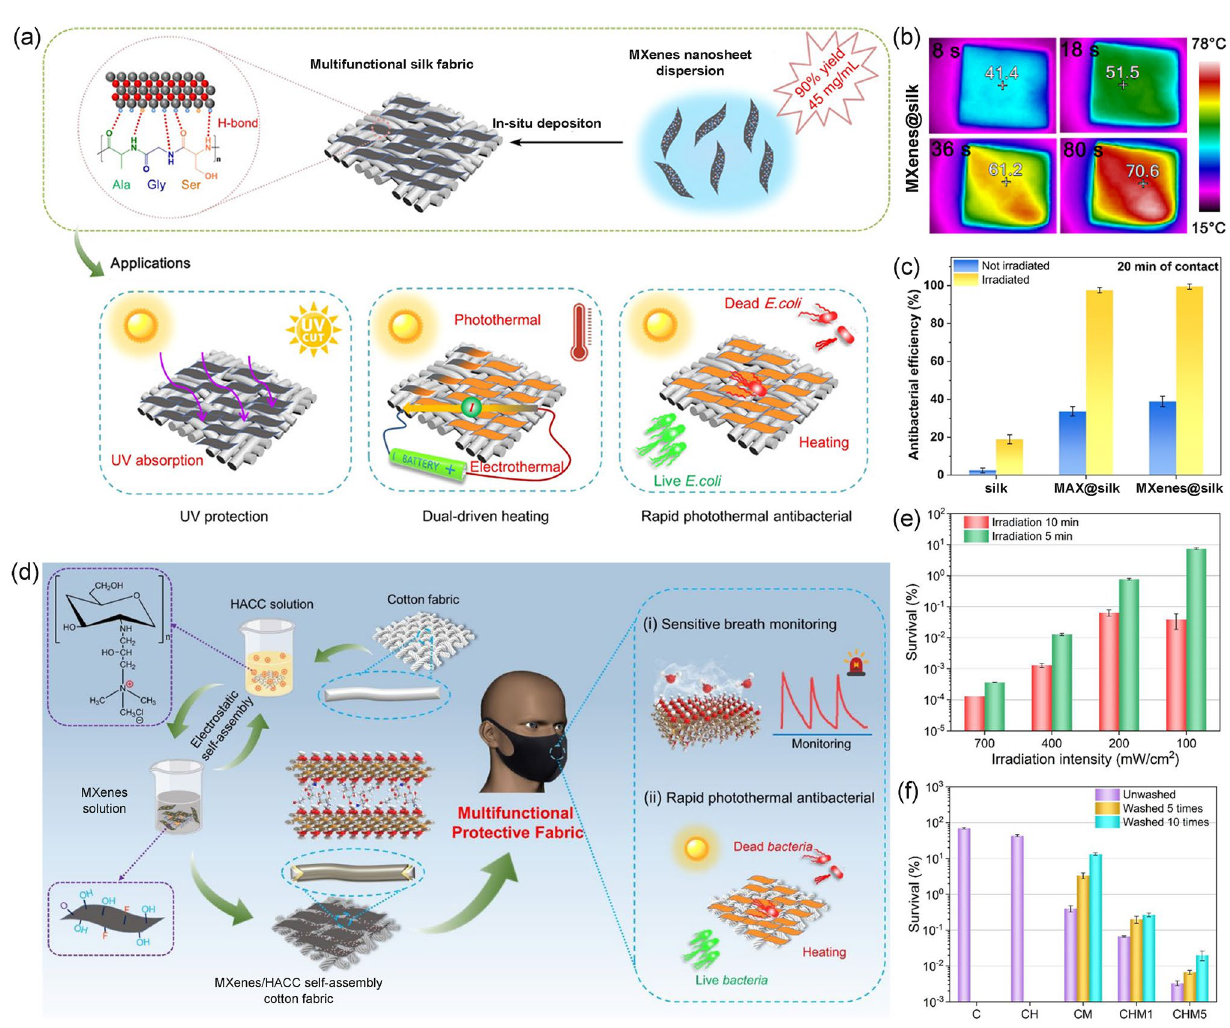
Fig. 13 a Schematic illustration of preparation and derivative functions of MXenes-based multifunctional silk fabric; b IR thermal images of the MXenes@silk; c The antibacterial efficiency of the different samples contacted for 20 min [45]. Copyright 2021, American Chemical Soci- ety. d Schematic illustration of preparation and application of multifunctional protective MXenes/HACC cotton fabric; e Antibacterial activity with different irradiation intensity and time; f Inactivation of fabric samples against E. coli and S. aureus before and after washing [141]. Copy- right 2022, American Chemical